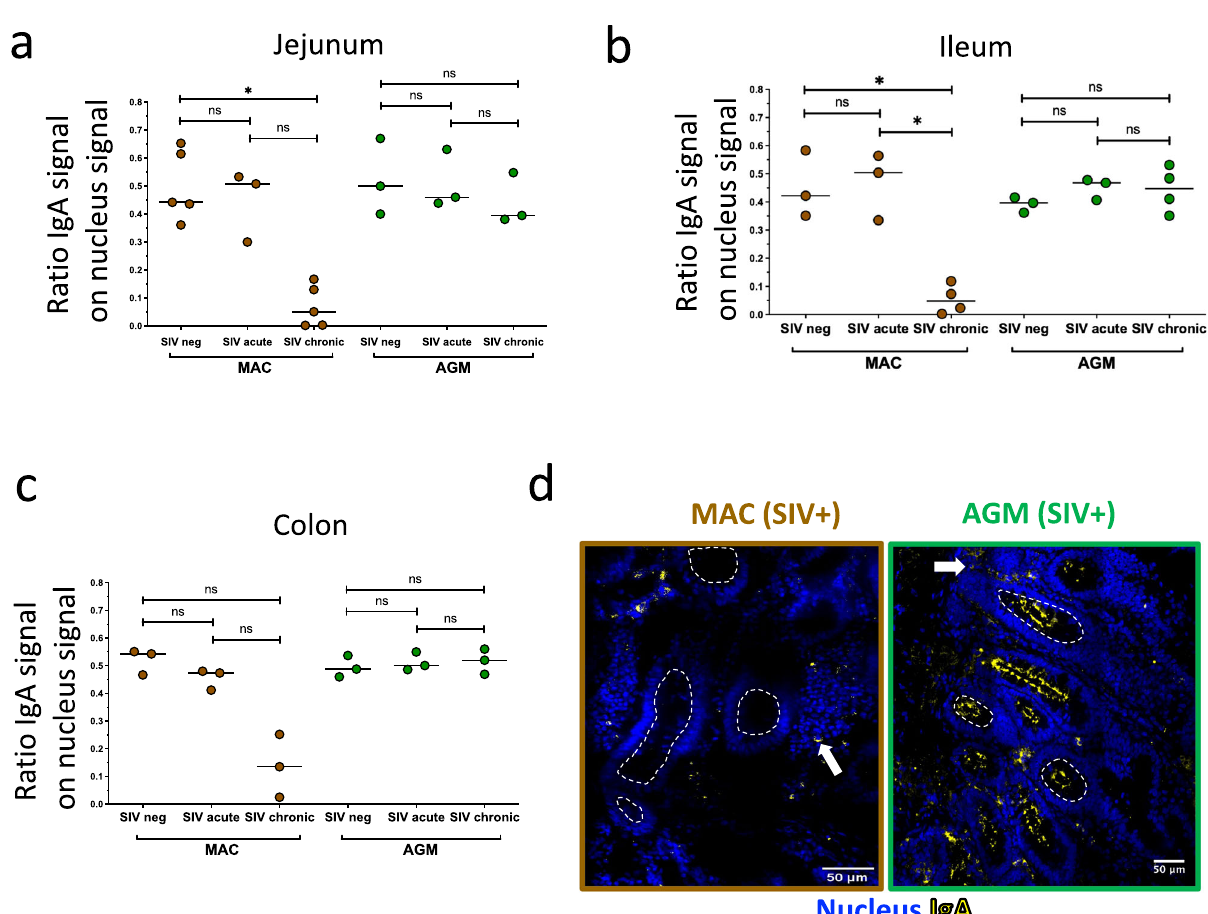
Fig. 2 Ig dynamics and anatomical distributions during SIVagm and SIVmac infections in the intestine. a – c Longitudinal evaluation of IgA levels in the intestine. The ratio of the IgA signal per nucleus signal was measured by microscopy in a jejunum, b ileum, and c colon in non-infected (SIVneg) and SIV- infected at day 9 p.i. after infection (SIVacute) and chronic SIV infection (SIVchronic) in MAC (brown) and AGM (green). Three non-infected MAC (ileum, colon), fi ve non-infected MAC (jejunum) and three non-infected AGM (jejunum, ileum, colon) were analyzed. Three MAC (jejunum, ileum, colon) and three AGM (jejunum, ileum, colon) were analyzed at day 9 p.i. Three chronic MAC (colon), four chronic MAC (ileum), fi ve chronic MAC (jejunum), four chronic AGM (ileum) and three chronic AGM (jejunum, colon) were analyzed. A nonparametric Mann – Whitney test ( p ≤ 0.05 = *; p ≤ 0.01 = **; p ≤ 0.001 = ***) was used. d Enlargements of the immuno fl uorescence staining of IgA (yellow) and nucleus (blue) in the colon from chronically SIVmac- infected MAC and chronically SIVagm-infected AGM (three chronic MAC and three chronic AGM). Arrows represent IgA + cells and circles delineate the lumen zone. The images show a representative section in the ileum for one MAC and one